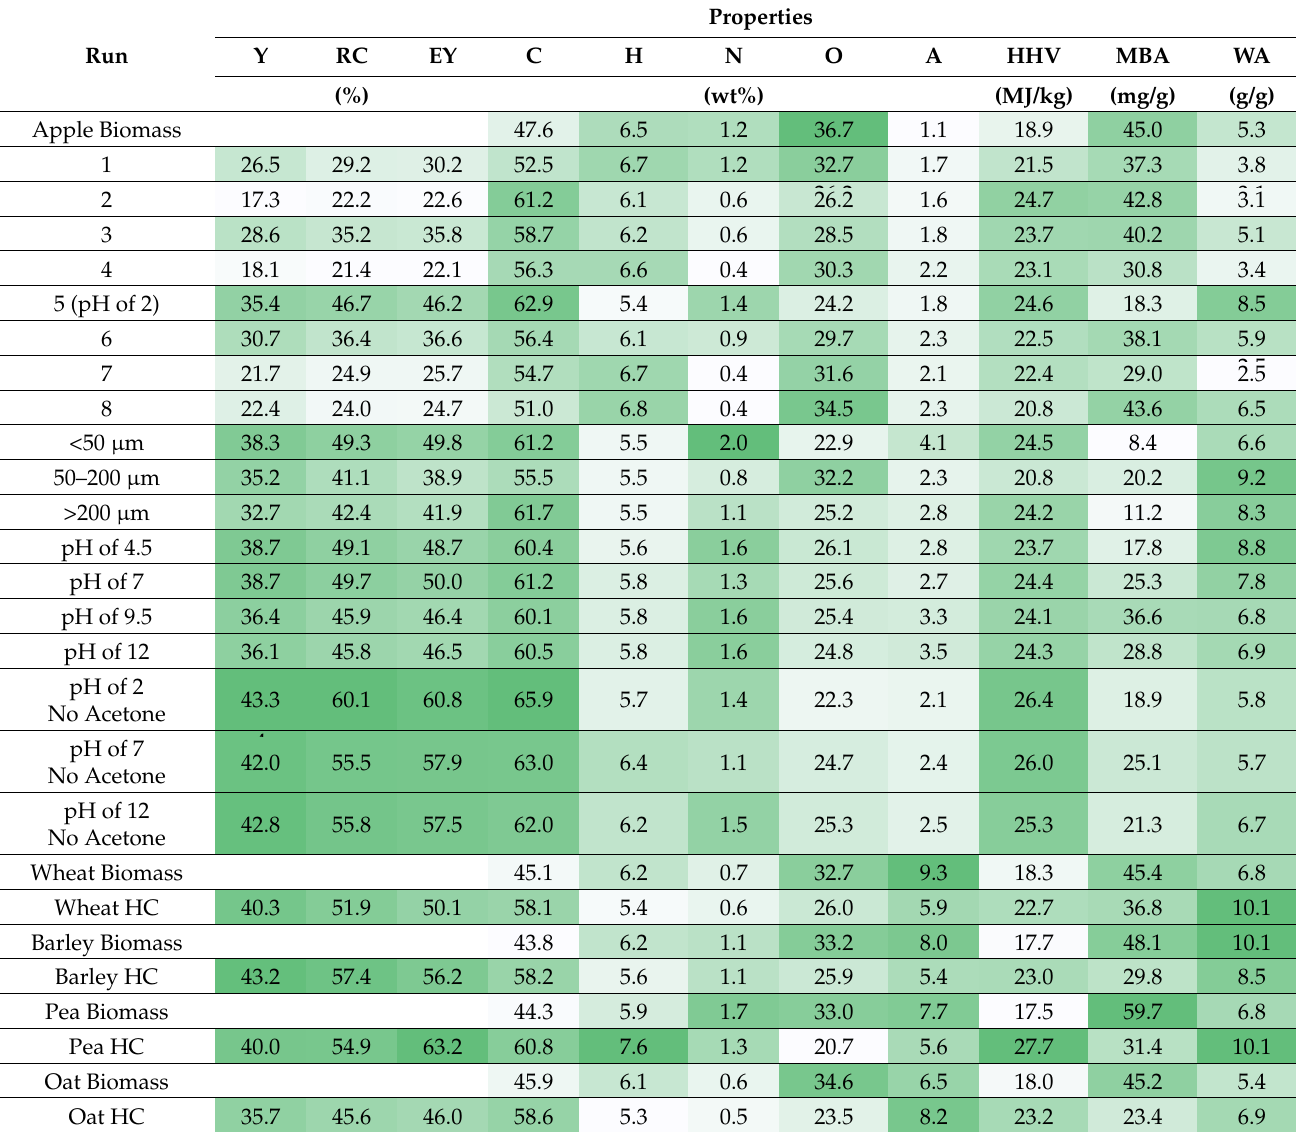
Table A2. HC results sectioned into the effect of process conditions, the effect of particle size, the effect of pH, the effect of acetone washing and the effect of feedstock and raw biomass results, with a colour